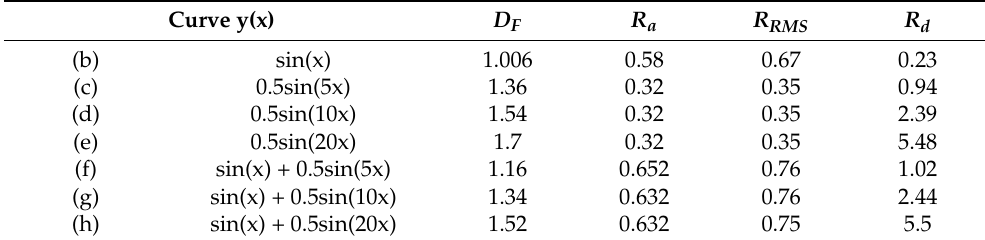
Figure 13. Bar graphs of the R a , R RMS, R d , and D F values ( a ) calculated for analytically defined sinusoidal curves ( b – h ). Table 2. Roughness estimates for sinusoidal